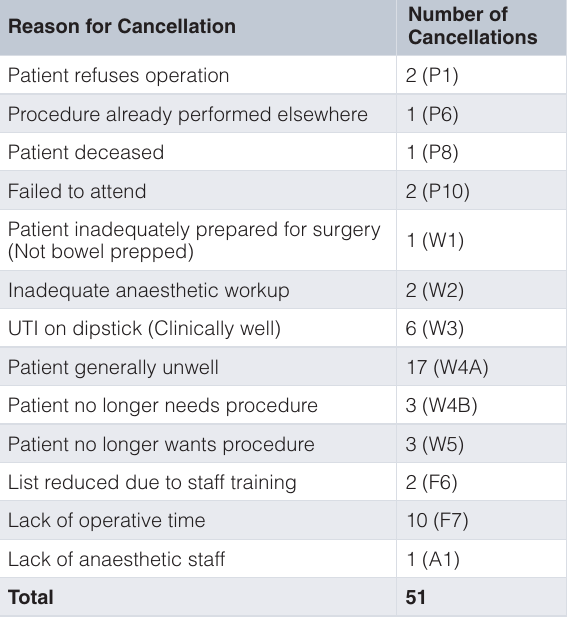
Table 8. The frequency of individual cancellation classification codes used for day of surgery cancellations during the audit period. Cancellation reasons are classified as per Argo et al’s cancellation codes 11